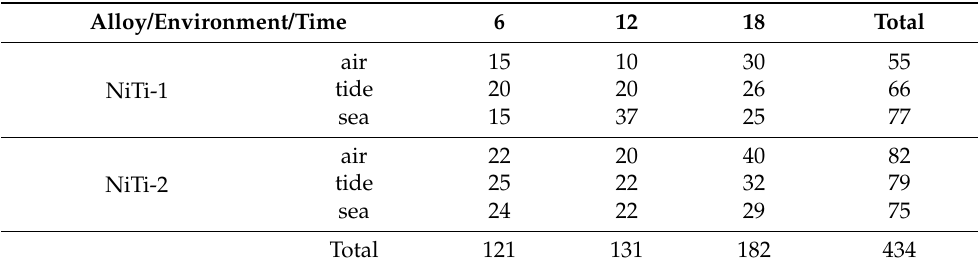
Table 4. The number of measurements performed on each alloy in different seawater environments after 6, 12 and 18 months of